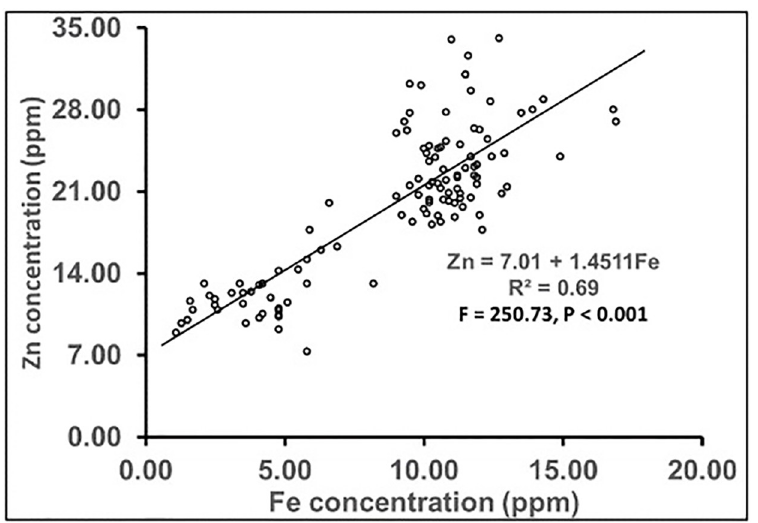
Fig 2. Linear regression showing Zn concentration as a dependent variable on Fe concentration.